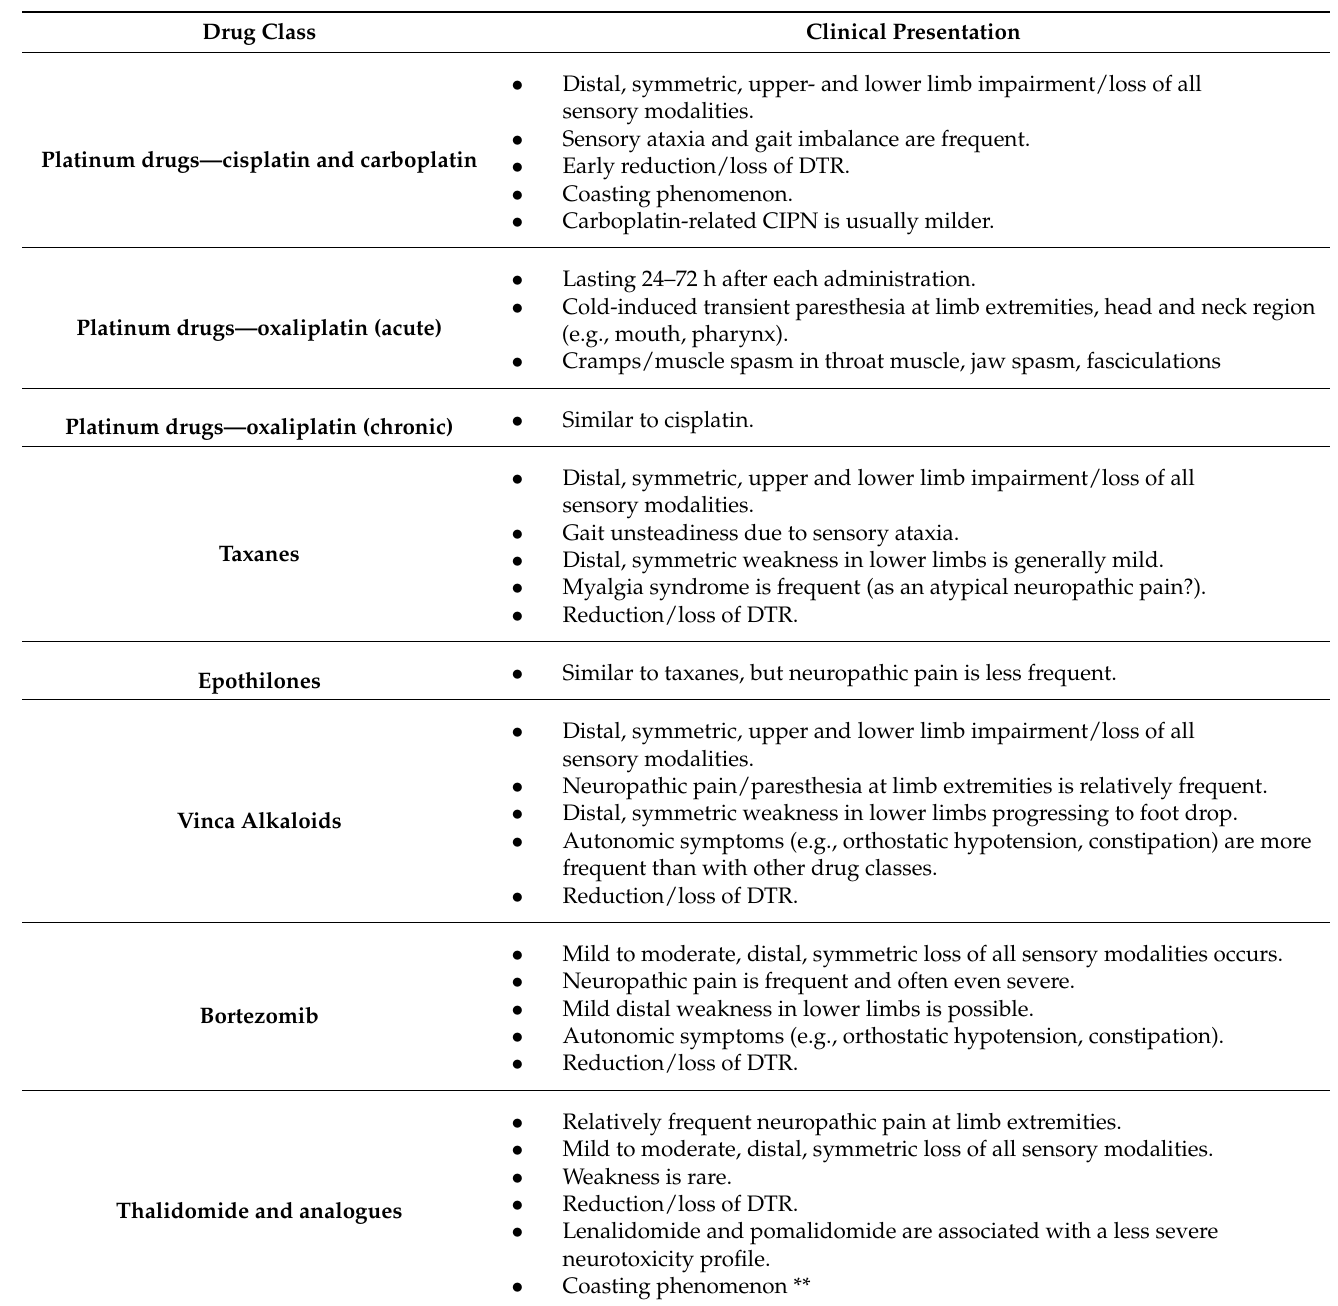
Table 1. CIPN clinical presentation for the different drug